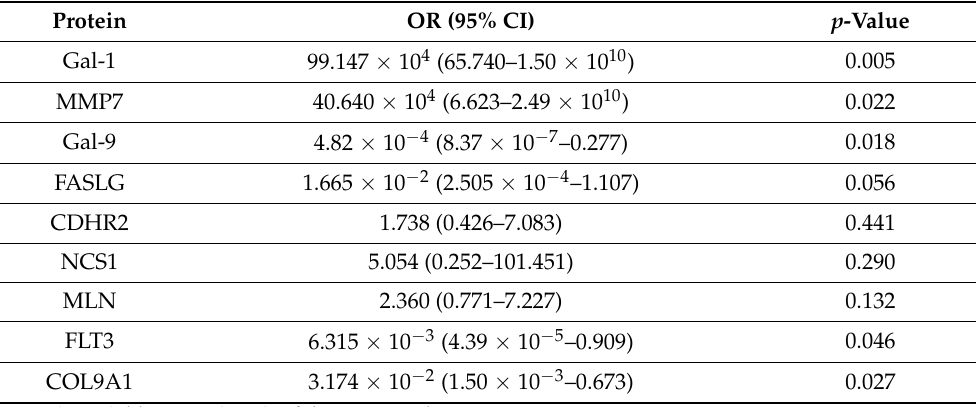
Table 9. Multivariate logistic regression model including all variables from the final model of the immuno-oncology and oncology panels.